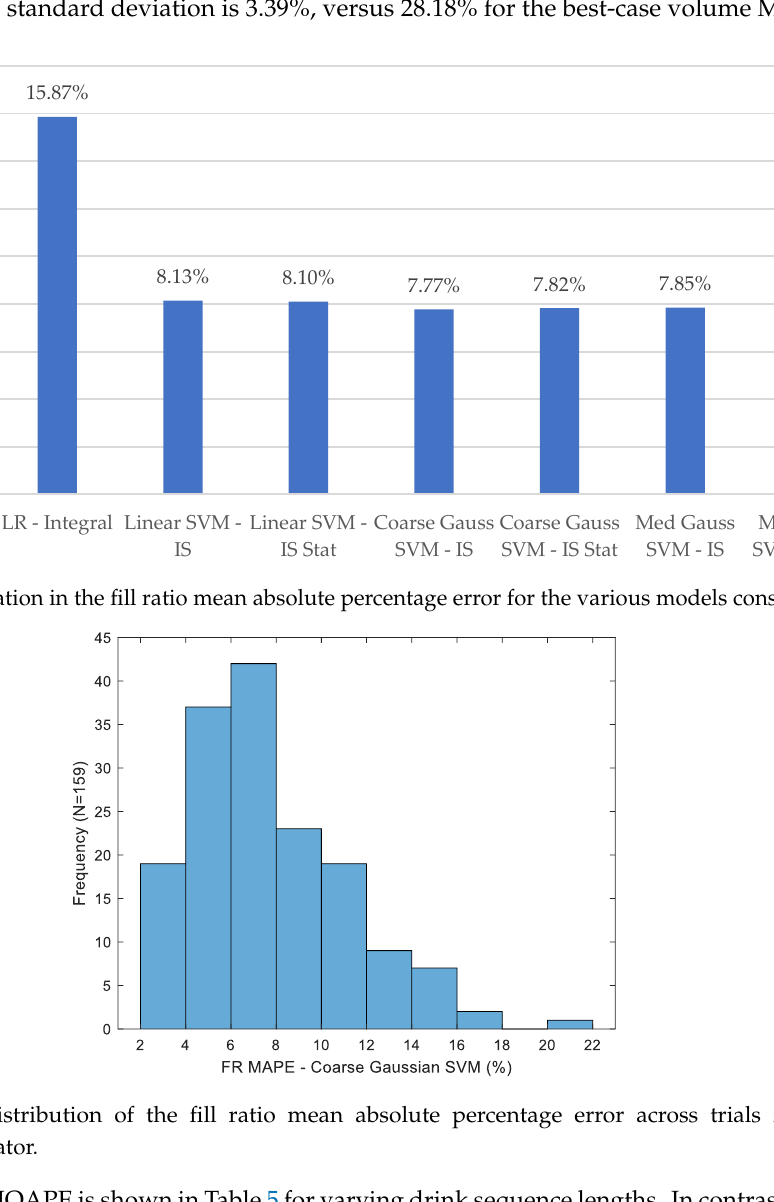
Table 5. Variation in the mean overall absolute percentage error for multiple prompt periods – fill ratio estimation (bold values emphasize the best performing model for each period).